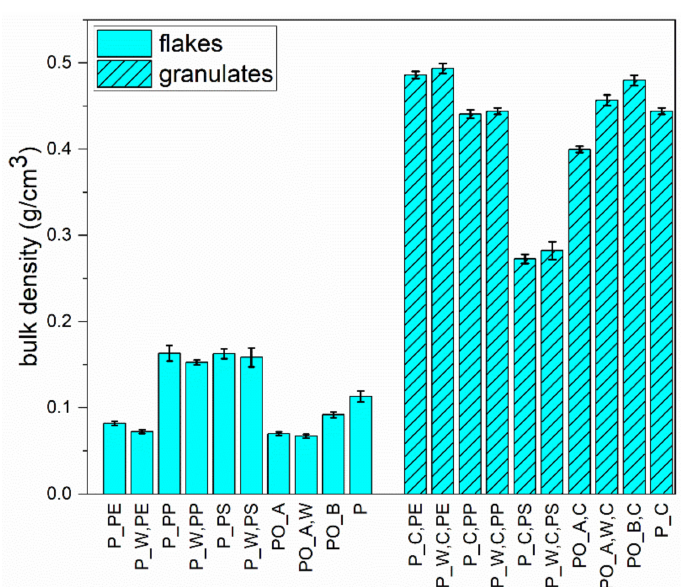
Figure 5. Determined bulk densities of all investigated materials before (flakes <4 mm) and after homogenisation